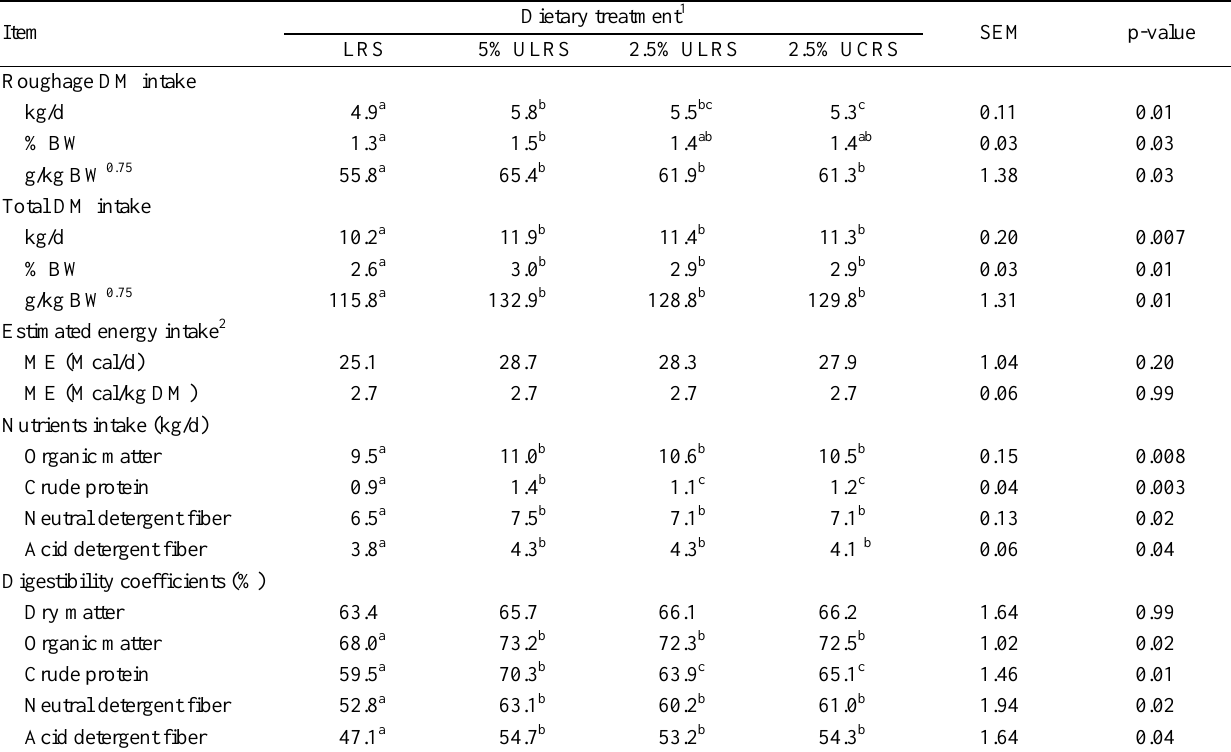
Table 2. Effects of physical forms and urea treatment of rice straw on feed intake and nutrient digestibility in lactating dairy cows Item